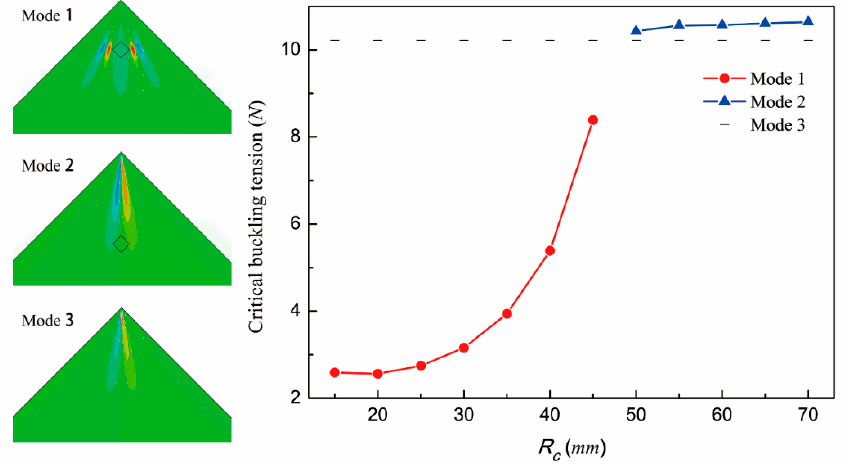
Figure 5. The critical buckling tension of the membrane when the rigid element is at different posi- tions.